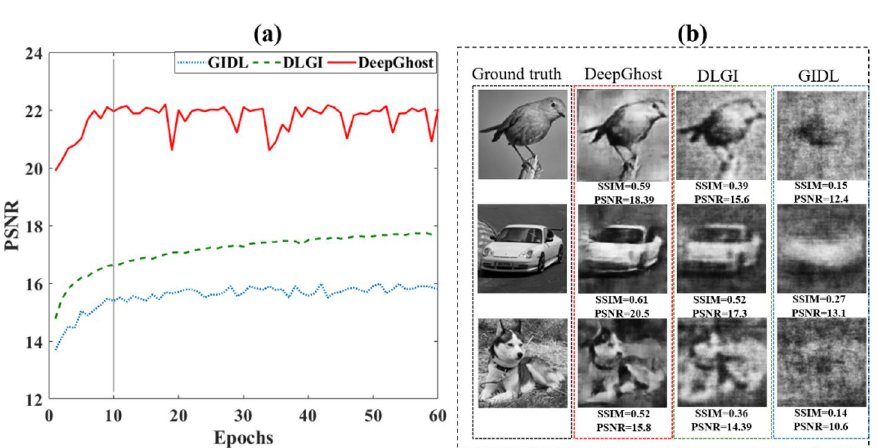
Figure 4. Performance comparison (for GIDL, DLGI, and DeepGhost) ( a ) on test set during training, ( b ) qualitative and quantitative comparison of